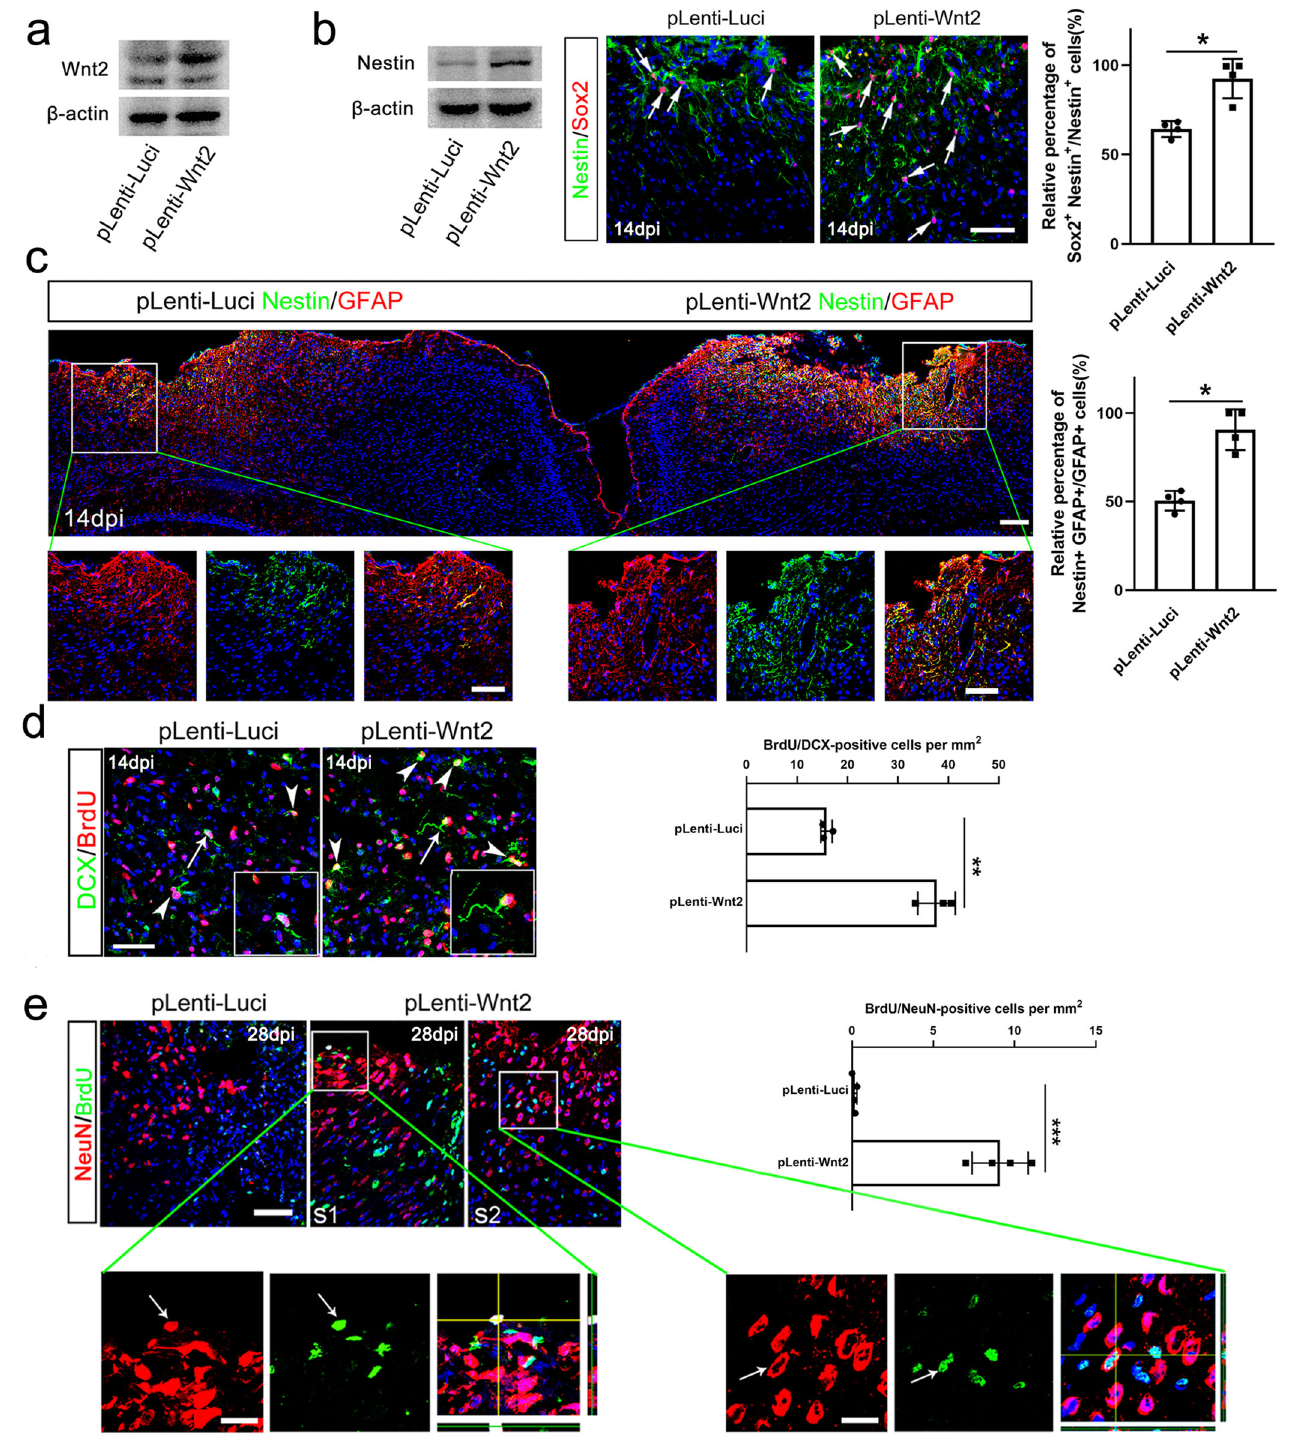
Fig. 4 Effects of Wnt2 over-expression on astrocyte dedifferentiation and cortical neurogenesis. a Western-blotting of Wnt2 in ischemic cortex infected by pLenti-Luci (control) and Wnt2. b Western-blotting of Nestin and double-immunostaining of Nestin/Sox2 in ischemic cortex infected by pLenti-Luci (control) and Wnt2. Bar = 50 μ m. N = 4 mice per group. c Representative images of Nestin/GFAP double- immunostaining in the bilateral cortices at 14 dpi with two ischemic injures infected by pLenti-Luci (left) and Wnt2 (right) respectively. Bar = 200 μ m in upper panel. Bar = 50 μ m in enlarged view. N = 4 mice per group. d Double-immunostaining and quanti fi cation of DCX/BrdU in ischemic cortex infected by pLenti-Luci and Wnt2. N = 3 mice per group. ** P = 0.0075. Two-tailed Student ’ s t test. Bar = 50 μ m. e Double- immunostaining and quanti fi cation of NeuN/BrdU in ischemic cortices infected by lentivirus expressing luciferase (control) or Wnt2. S1 and S2 are two representative sections showing one NeuN/BrdU-positive cell in each section. Arrows point to double-stained cells. Bar = 30 μ m, and 5 μ m in insert. *** P < 0.001. Two-tailed Student ’ s t test. N = 4 mice per group. Mean ± standard error (SE). Asterisks with bars connecting two groups indicate difference between these two